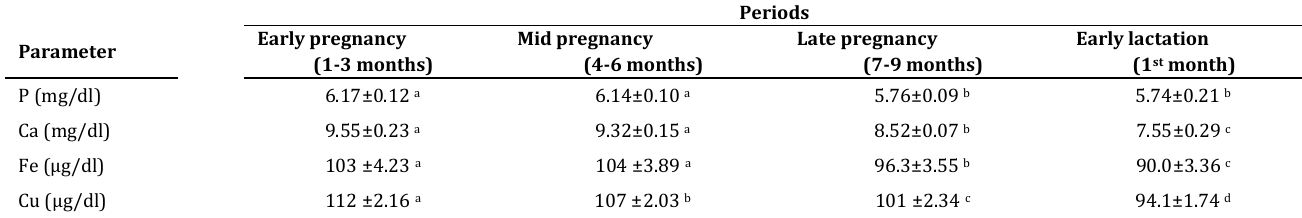
Table 2. Serum parameters through pregnancy periods and early lactation